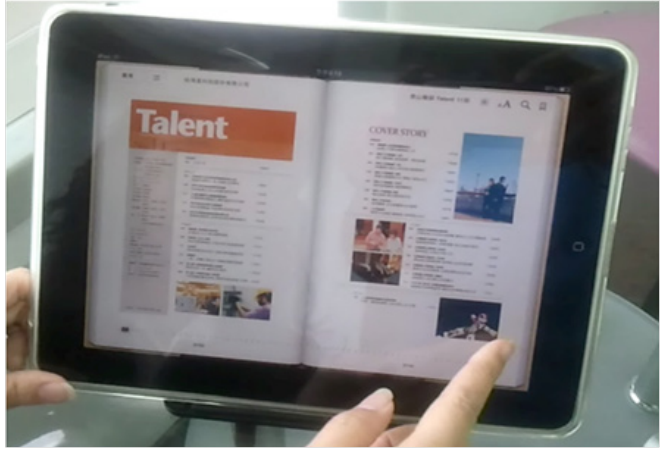
Figure 7 . E-book Hub on a device with an Android operating system.